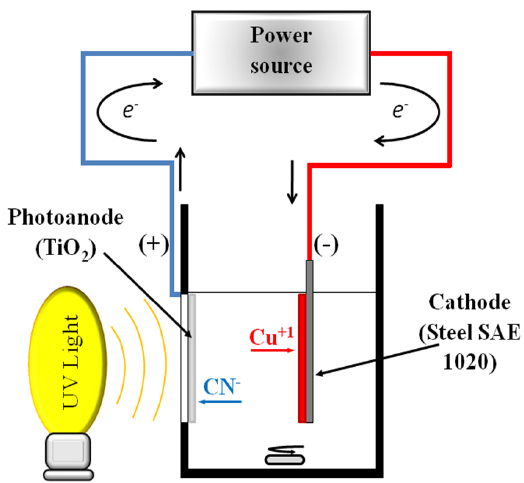
Figure 1. Schematic representation of the cell employed for photo‑ assisted Copper ions